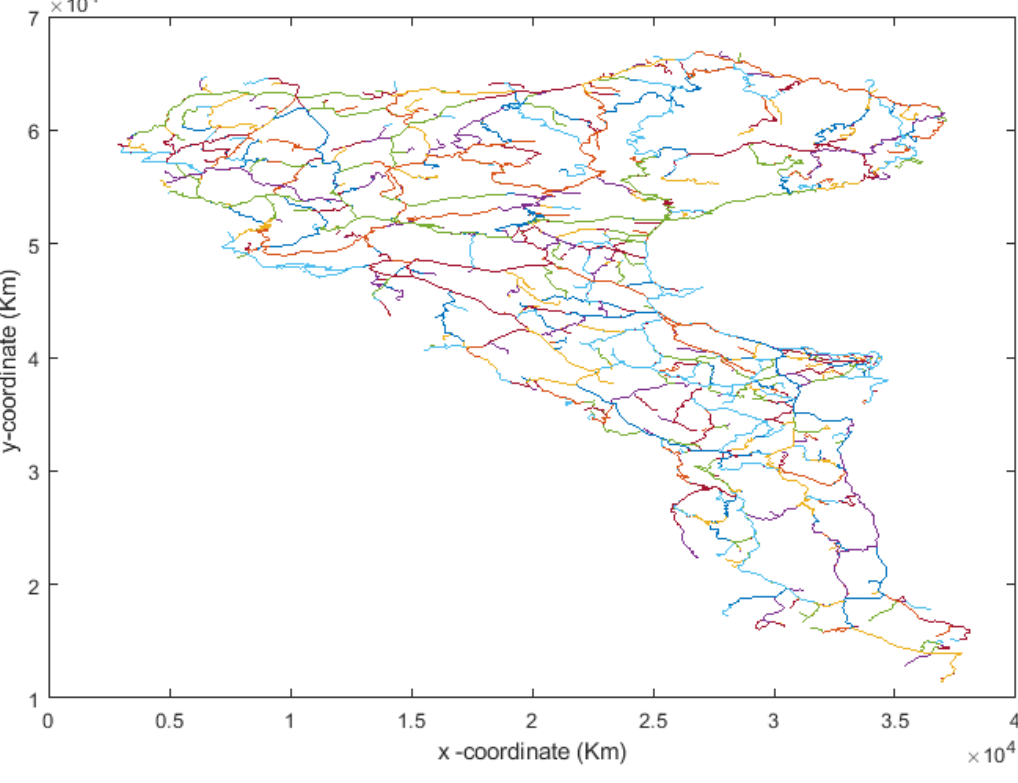
Figure 3. A Matlab overview of mobile users trajectories’